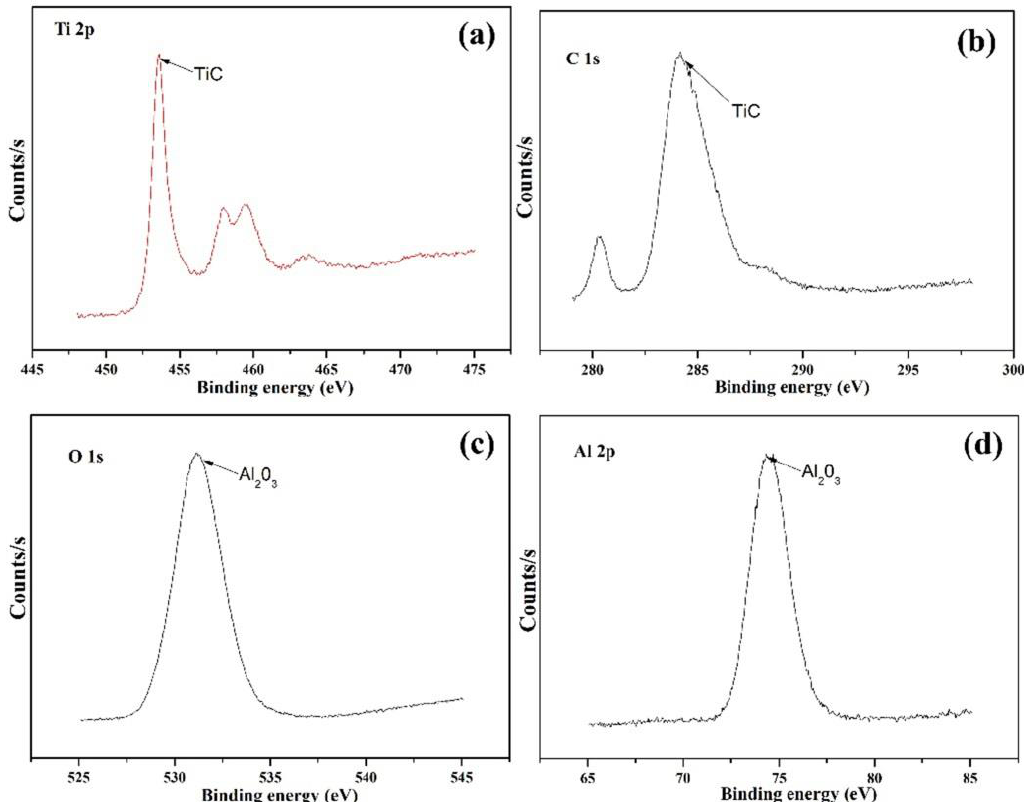
Figure 10. X-ray photoelectron spectroscopy (XPS) element valence diagrams of the composite coating with Ti 3 SiC 2 : ( a ) Ti 2 p ; ( b ) C 1 s ; ( c ) O 1 s ; ( d ) Al 2 p .